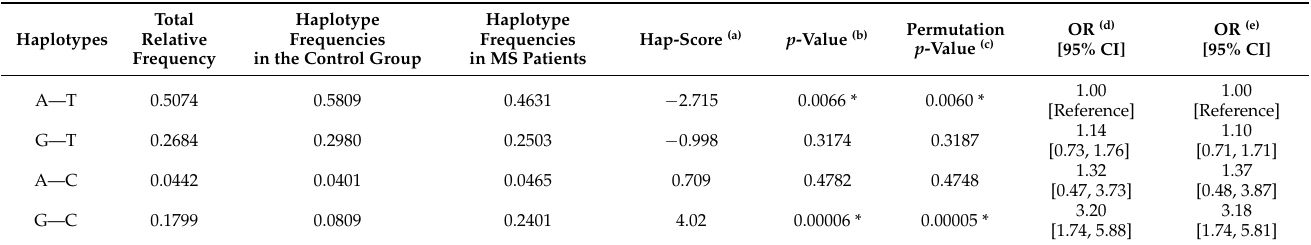
Table 5. Haplotype analysis for association of IL-27 gene polymorphisms ( A964G and T4730C ) with MS odds.